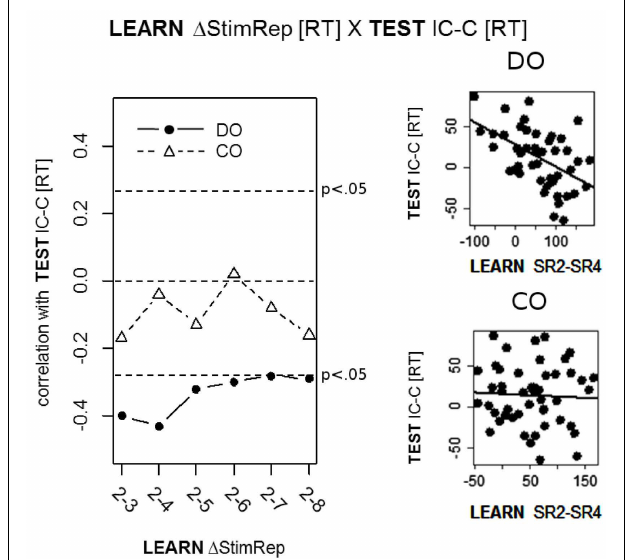
FIGURE 3 | Correlations between response times (RT) during ongoing learning and RTs during the subsequent response-effect (R-E) compatibility test in Exp. 1. Ongoing learning is expressed in terms of the RT difference between Stimulus Repetition (StimRep) 2 and the subsequent StimRep levels (i.e., ∆ StimRep). R-E compatibility is expressed in terms of the RT difference between incompatible (IC) and compatible (C) test